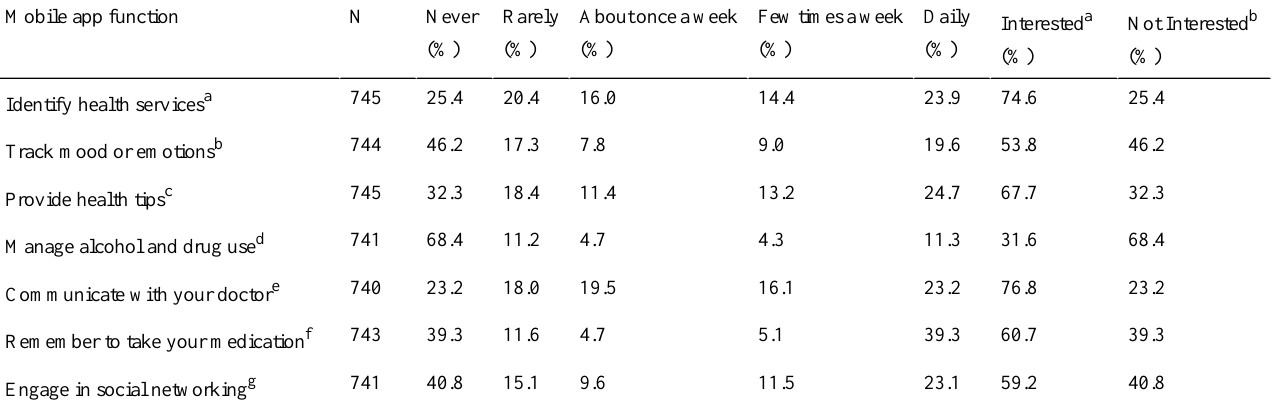
Table 2. Interest in mobile phone app functions to support HIV self-management.